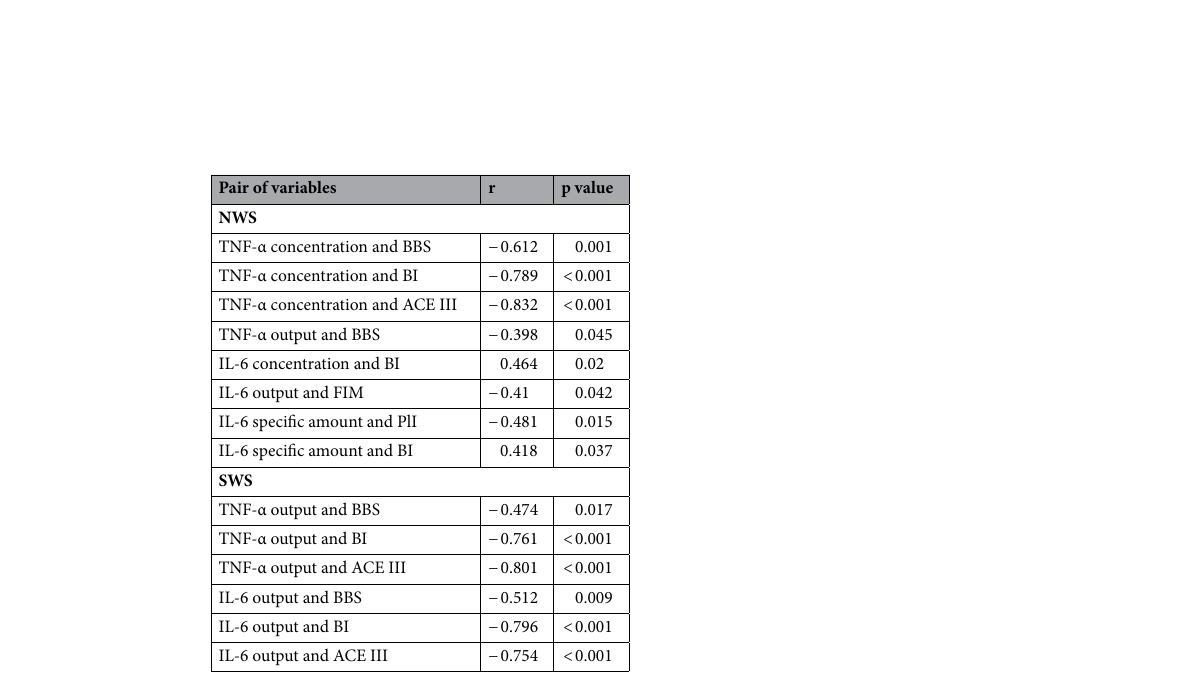
Table 5. Statistically significant correlations in patients with ischemic stroke. NWS non-stimulated whole saliva, SWS stimulated whole saliva, TNF-α tumor necrosis factor α, IL-6 interleukin 6, PLI Plaque Index, ACE III Addenbrooke’s Cognitive Examination, FIM functional independence measure, BBS Berg Balance